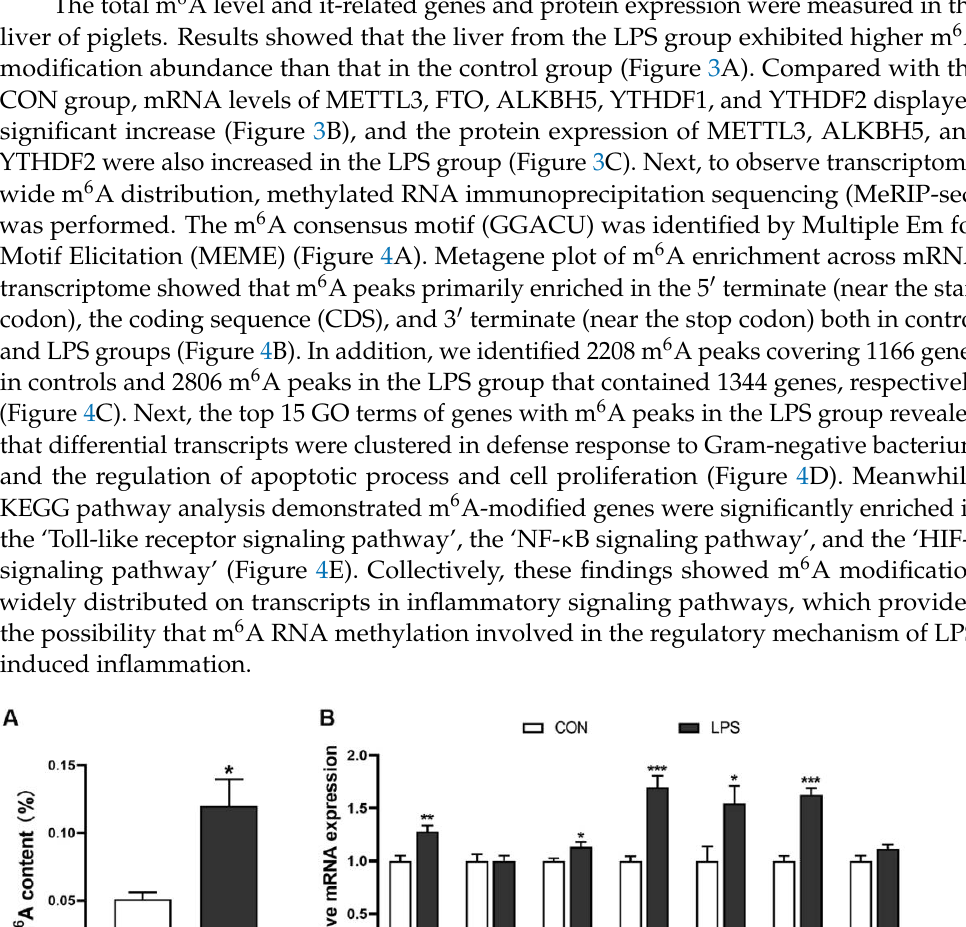
Figure 4. MeRIP-seq of transcriptome in the liver of CON and LPS groups. ( A ) Consensus m 6 A motif of the LPS group, as assessed by MEME. ( B ) Metagene profiles of m 6 A peaks across mRNA